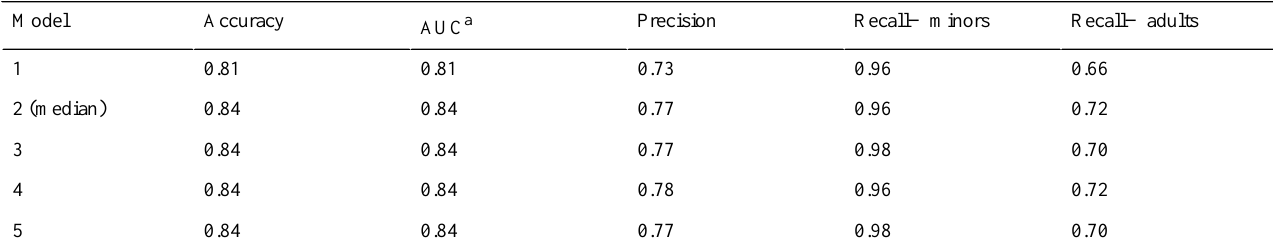
Table 9. Performance results for the random forest algorithm on each of the outer cross-validation test sets, for the female sample. Recall—adultsRecall—minorsPrecisionAUC a AccuracyModel